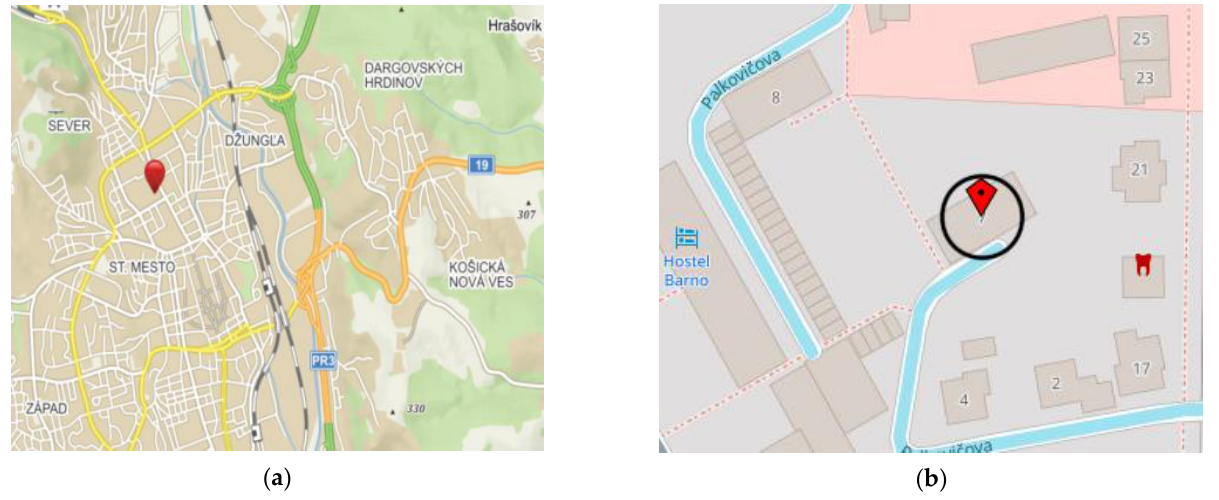
Figure 2. ( a , b ) The situation of a case study (according to https://mapa.zoznam.sk/, accessed on 21 January 2021). of the reference apartment and selected